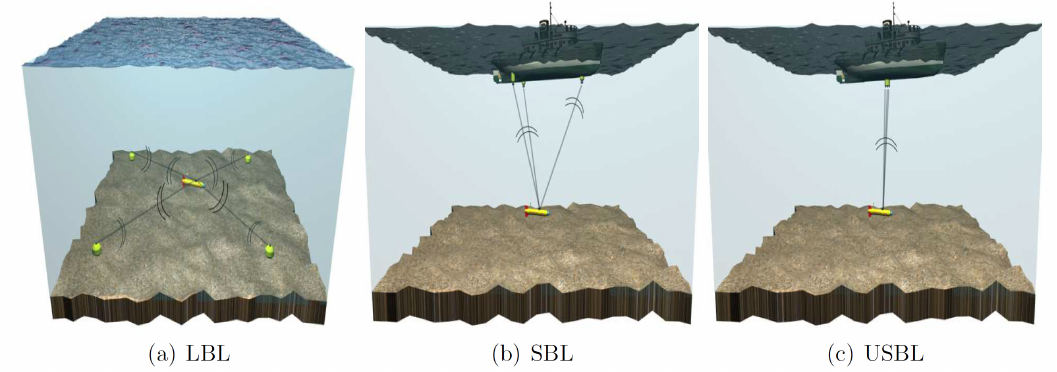
Figure 3. Classical underwater acoustic positioning systems for marine environments, reproduced from work presented by Alcocer et al.